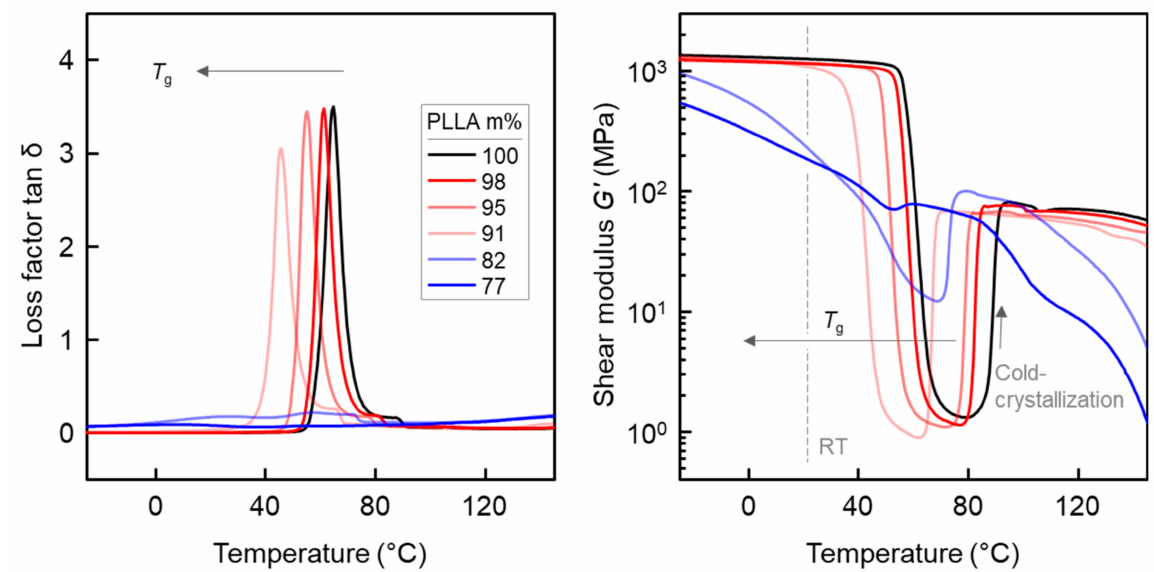
Figure 10. DMA curves, loss factor tan- δ ( left ) and shear modulus G ’ ( right ) as a function of temperature, respectively, of PLLA/IR3535 extrudates upon heating at 2